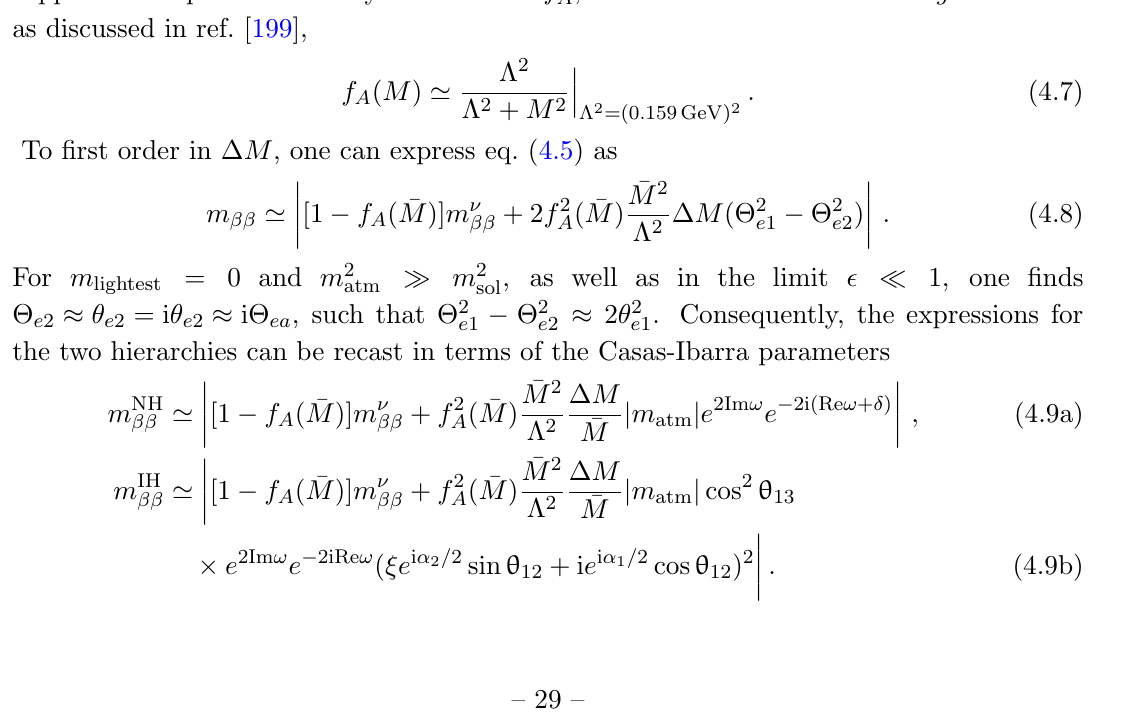
=U 2 such that the observed BAU can a =U 2 - U 2 =U 2 plane for inverted e (cid:22) U 2 =U 2 = a a